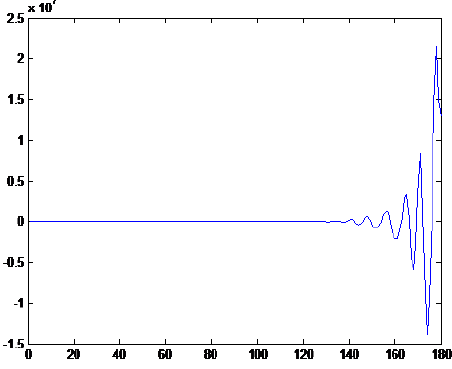
Figure 16. Stepresponse for 100% step input